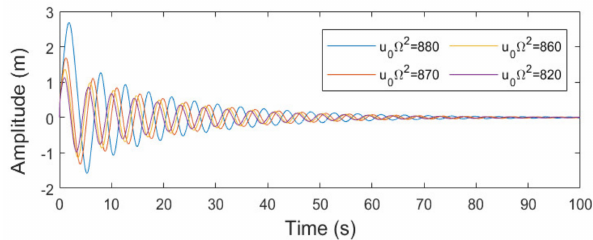
Figure 9. Displacement time histories.